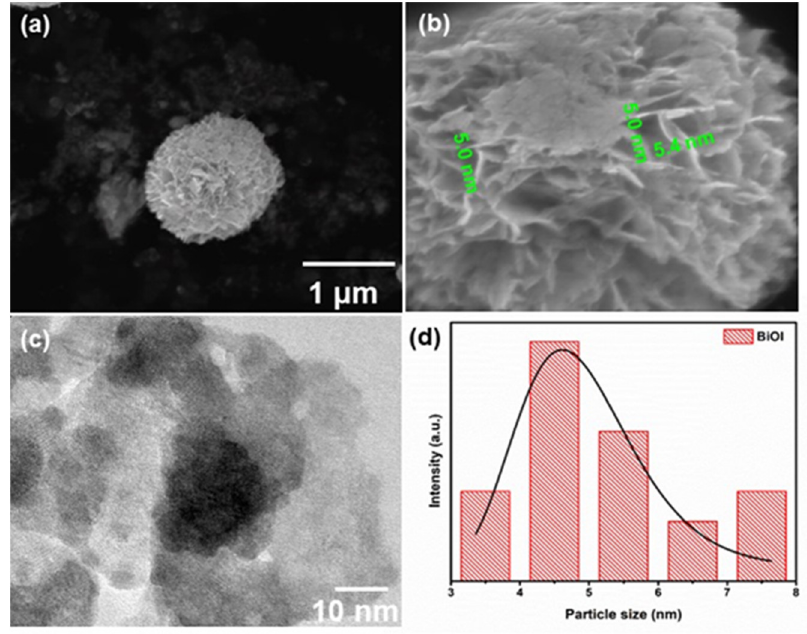
Figure 3. SEM ( a , b ) and TEM ( c ) images and distribution of particle size ( d ) of BiOI photocatalyst.